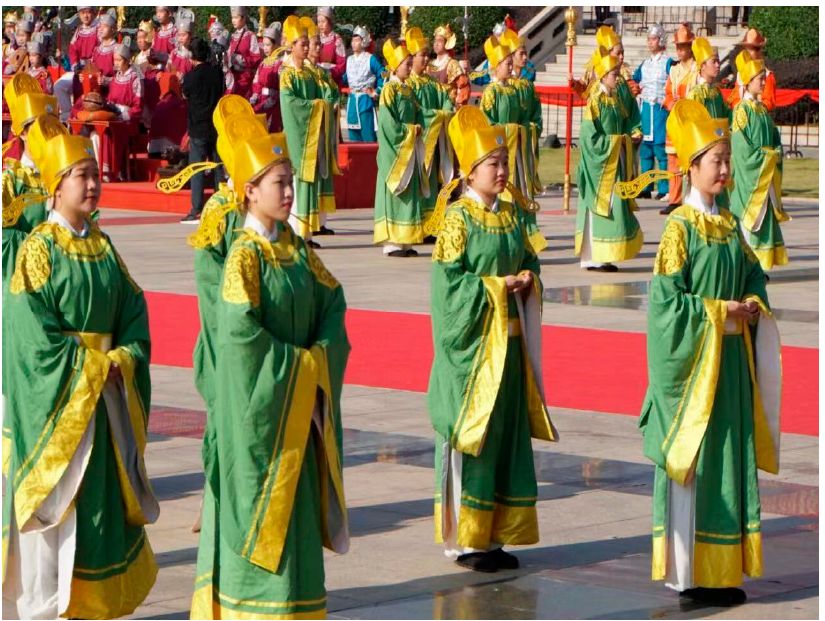
Figure 6. Female actors who play ritualists and cantors. Source: the website of Meizhou ancestral Table 323. https://weibo.com/mzmz323?re- fer_flag=1005055013_&is_all=1&ssl_rnd=1616329203.3123#_rnd1610641535373 Accessed on 10 July 2020. Reprinted with permission from the temple board of Meizhou ancestral temple.